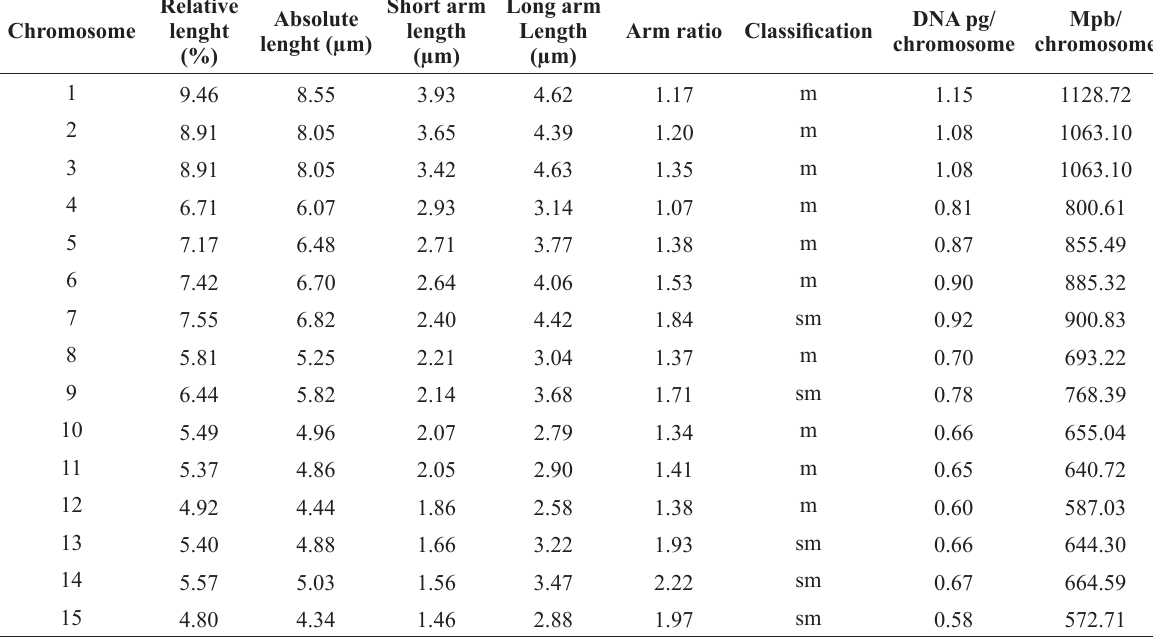
Karyology of A. africanus and estimative of DNA content for each